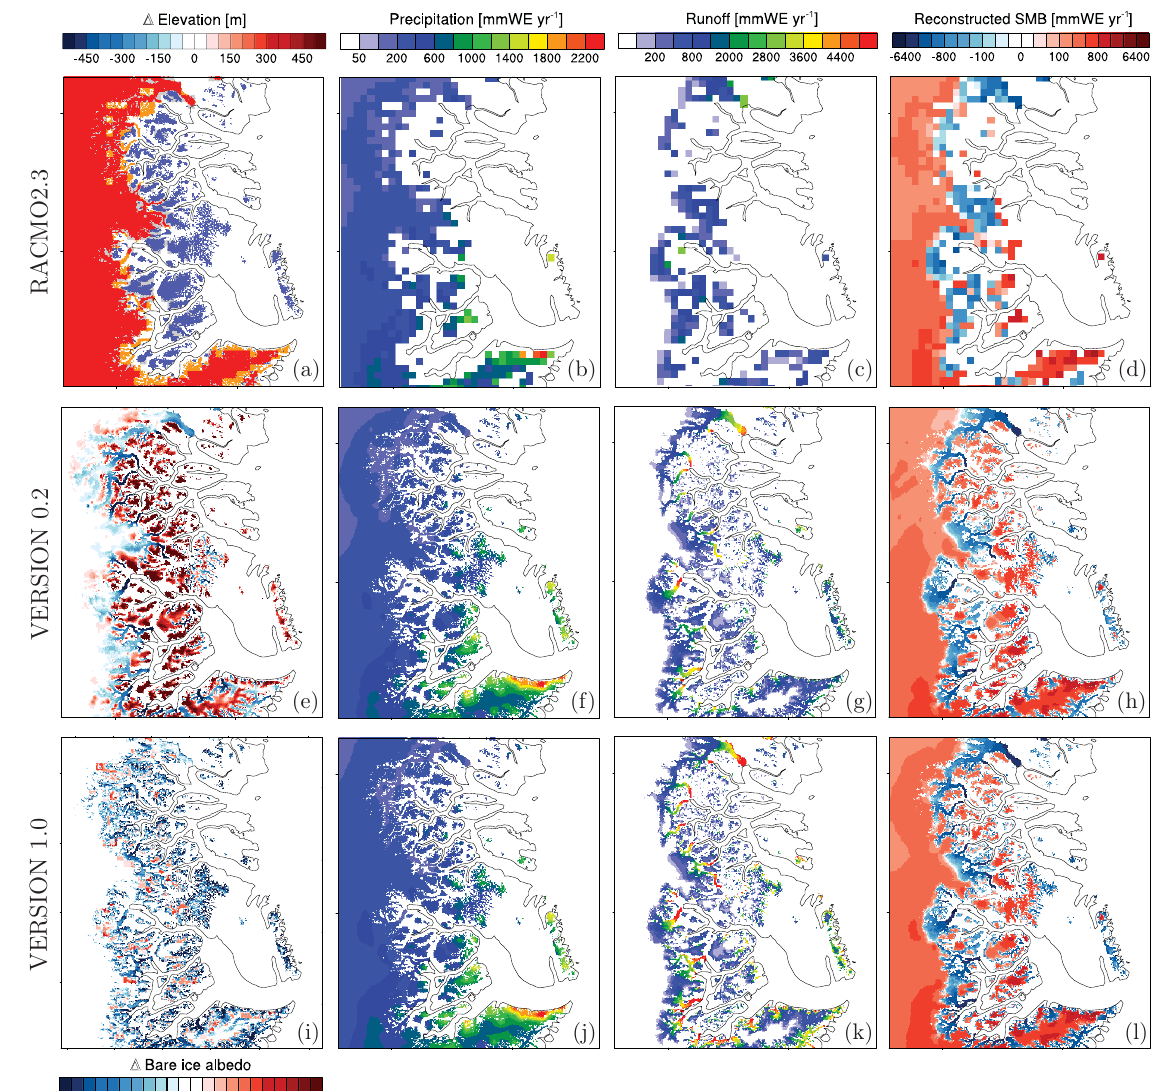
Figure 10. Centre east: (a) ice sheet mask in RACMO2.3 at 11km (red) and in the down-sampled GIMP DEM at 1km (orange) (blue box 1 in Fig. 1), and the mask of disconnected glaciers and ice caps at 1km (blue); average (1958–2015) annual mean (b) total precipitation, (c) runoff and (d) SMB (mmWEyr − 1 ) modelled by RACMO2.3 at 11km; (e) elevation bias (m) between 1 and 11km resolutions. Panels (f) , (g) and (h) represent annual mean total precipitation, runoff and SMB downscaled to 1km using elevation dependence only (v0.2). Panel (i) shows the bare ice albedo bias between MODIS measurements at 1km (2000–2015) and RACMO2.3 at 11km (2001–2010). Panels (j) , (k) and (l) are similar to (f) , (g) and (h) but incorporate the bare ice albedo and precipitation corrections